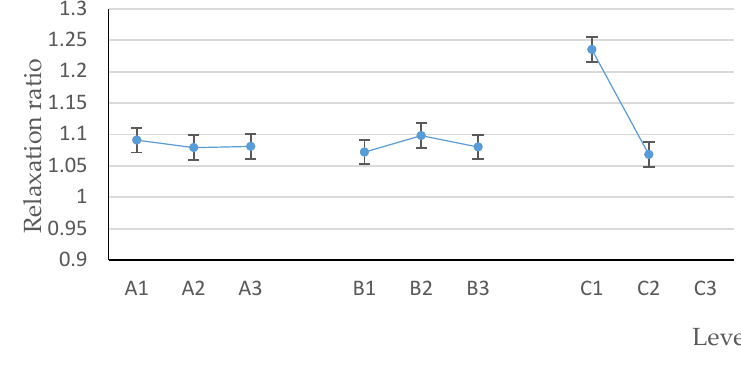
Figure 8. Factors and levels–relaxation ratio.